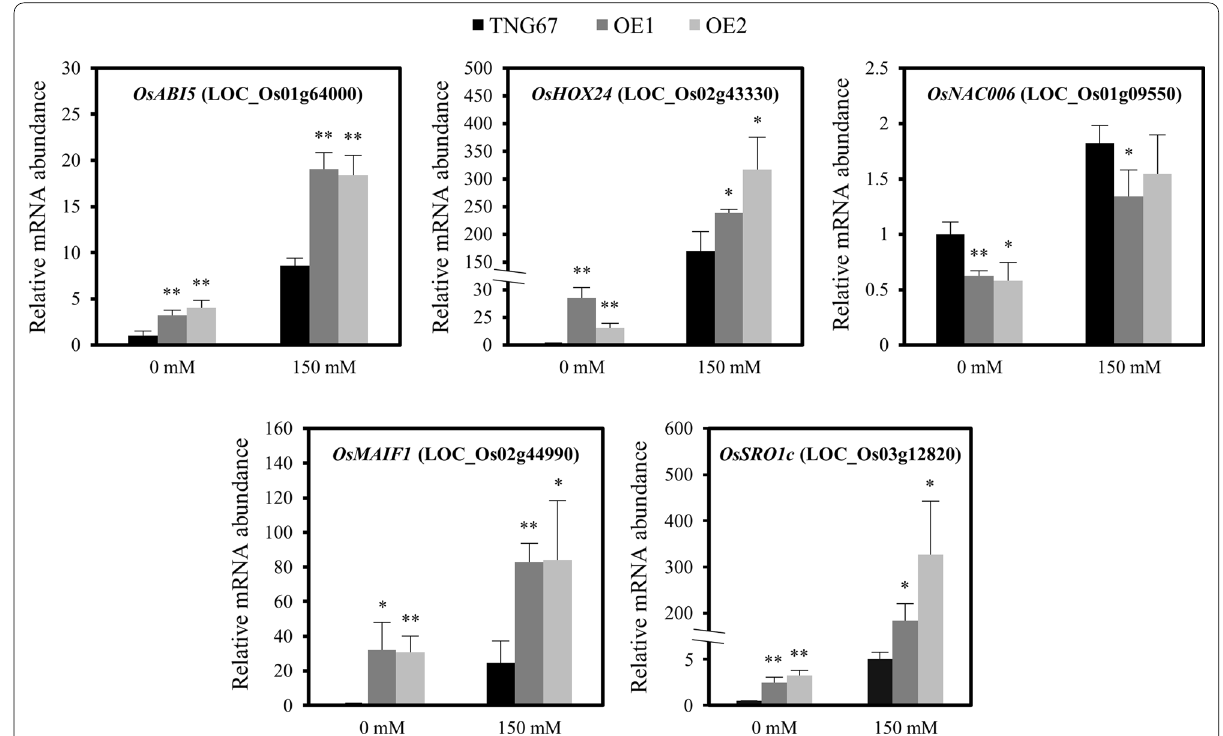
Fig. 7 Quantification of abiotic stress‑related DEG mRNAs in the shoots of two OsERF106MZ ‑overexpressing transgenic rice lines (OE1 and OE2) and Tainung 67 by qPCR. The values are the mean SE of five biological replicates, each with two technical replicates. Asterisks indicate significant ± differences (* P < 0.05 and ** P < 0.01) in comparison to the corresponding WT (Tainung 67) based on Student’s t ‑test. The total RNA used in the qPCR and microarray assays was isolated from the same shoots of 7‑day‑old seedlings treated with 0 or 150 mM NaCl for 1